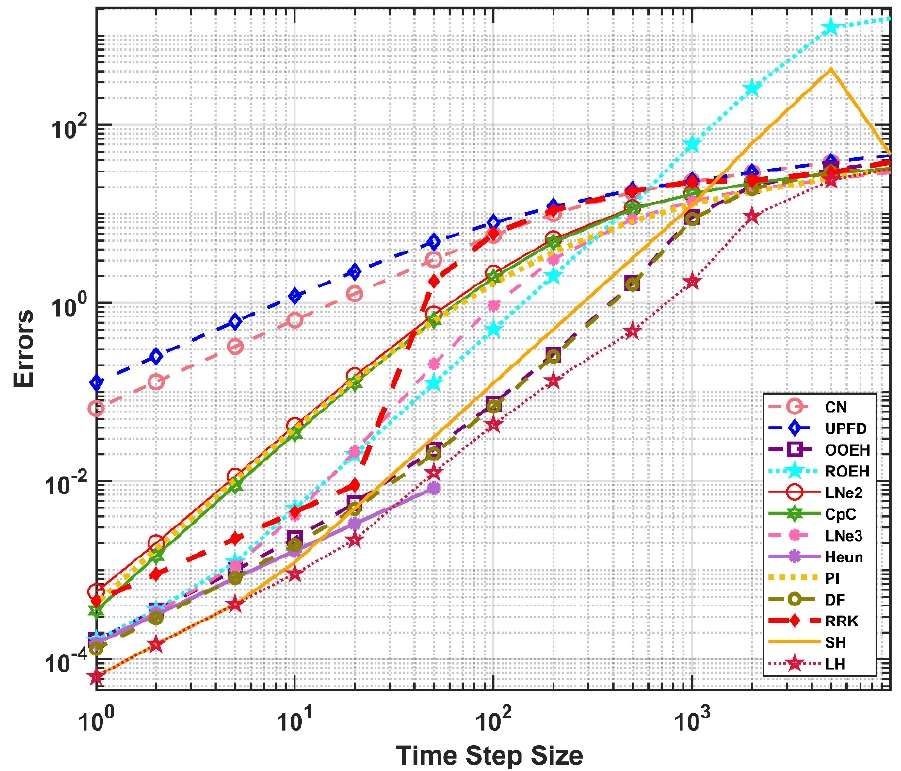
Figure 12. The L ∞ errors as a function of the time step size ∆ t for the equidistant mesh.